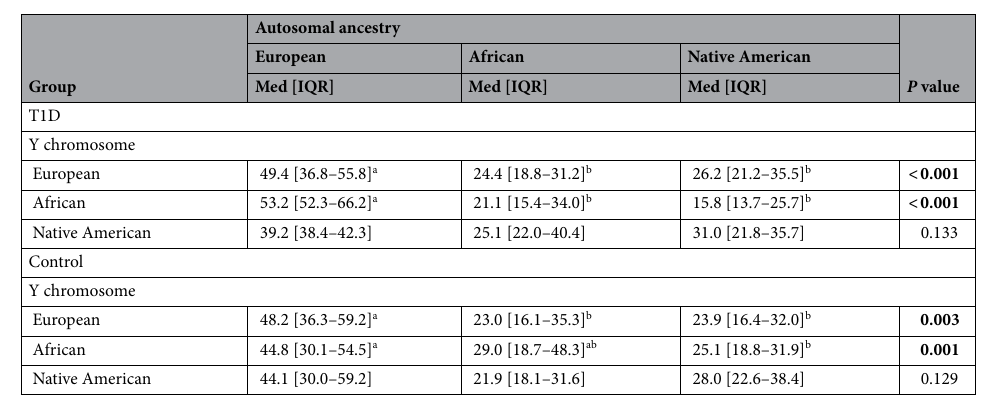
Table 4. Comparative analysis of autosomal ancestry according to Y chromosome ancestry of the Maranhão state T1D and control groups. Data are showed as median and interquartile range [IQR]. Different letters indicate significant differences between Y chromosome categories (ANOVA test port-hoc Bonferroni). T1D = type 1 diabetes. Bold indicates statistical significance ( P < 0.05).